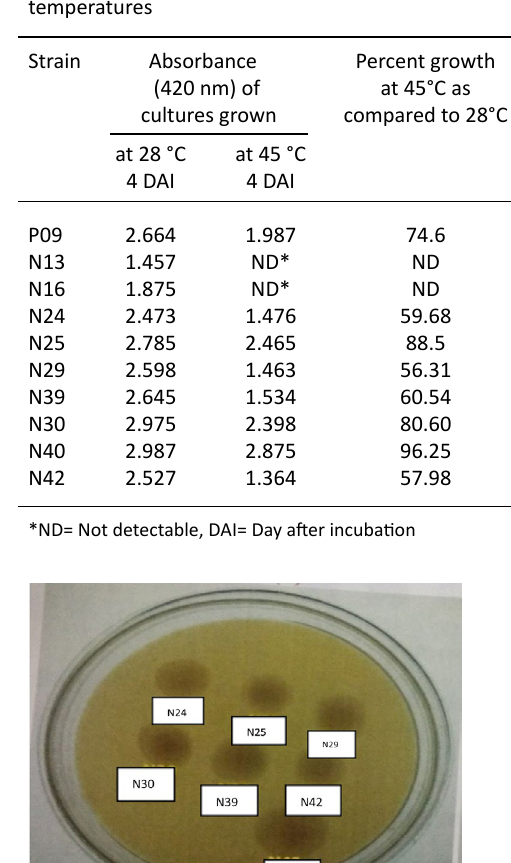
table 1. Growth and survival of Rhizobium